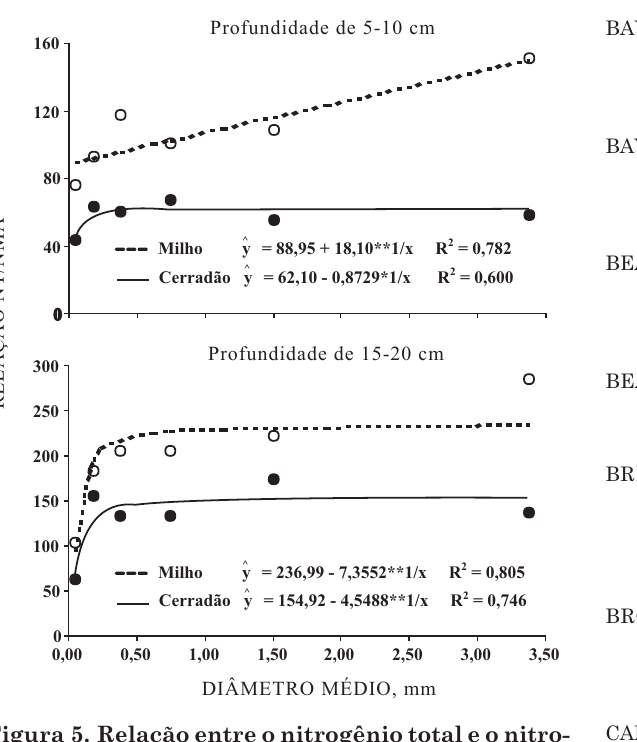
Figura 5. Relação entre o nitrogênio total e o nitro- gênio mineralizado anaerobicamente (relação NT/NMA), em função do diâmetro médio dos agregados, nas profundidades de 5–10 e 15–20 cm de um Latossolo Vermelho sob vege- tação natural de Cerradão e sob cultivo com milho por 30 anos. *, **: significativo a 5 e 1 %, respectivamente, pelo teste